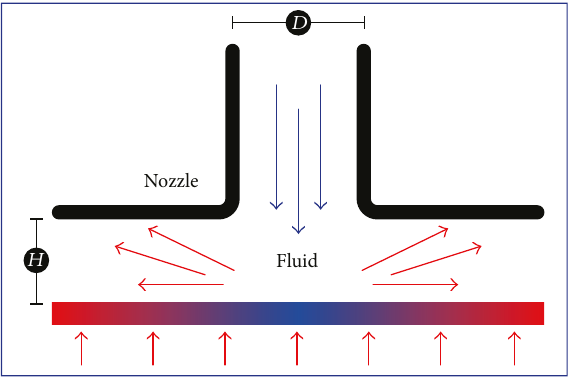
Figure 4: E ff ect of directed fl uid released against the heat transferring